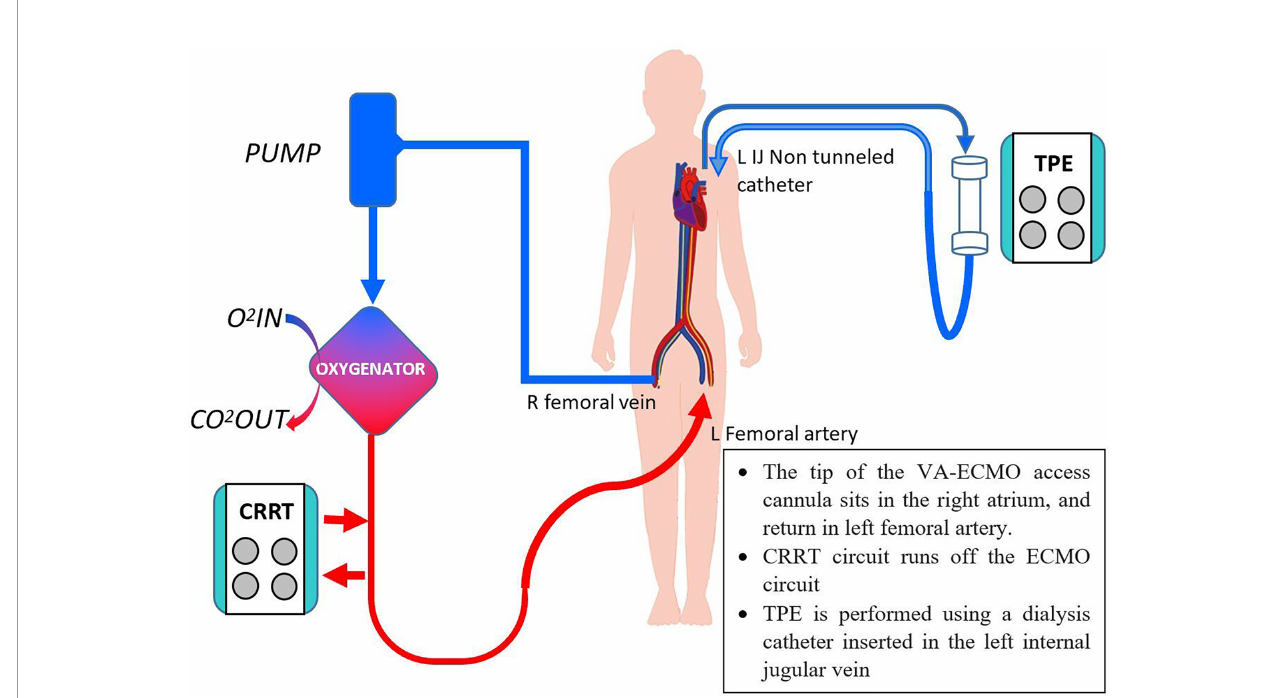
FIGURE 2 | Concurrent CRRT, VA-ECMO and TPE. O 2 , oxygen, CO 2 , carbon dioxide, others as per Figure 1